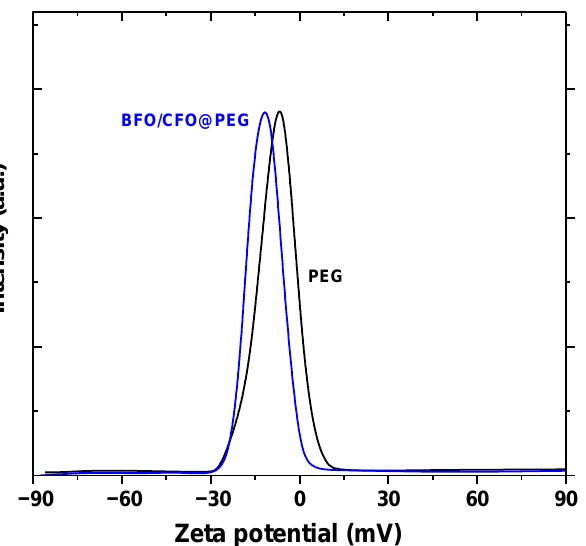
Figure 8. Zeta potential distribution of BFO/CFO and BFO/CFO@PEG nanoparticles (distilled water as dispersant).